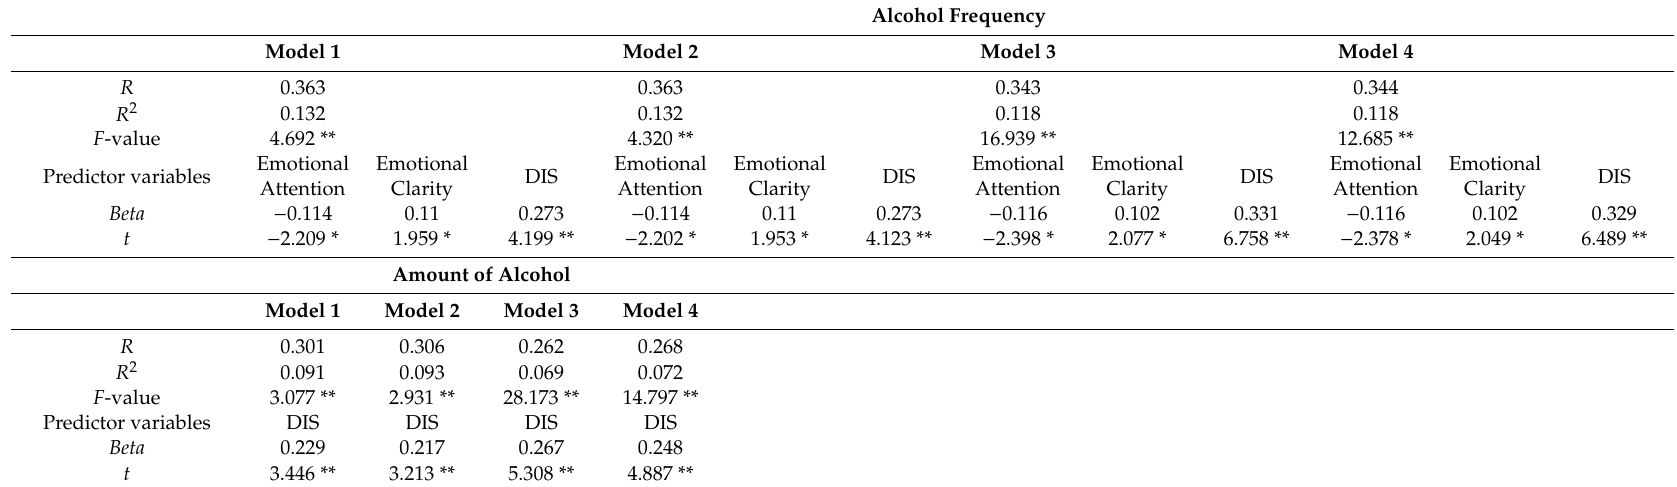
Table 3. Linear multiple regression analyses predicting alcohol